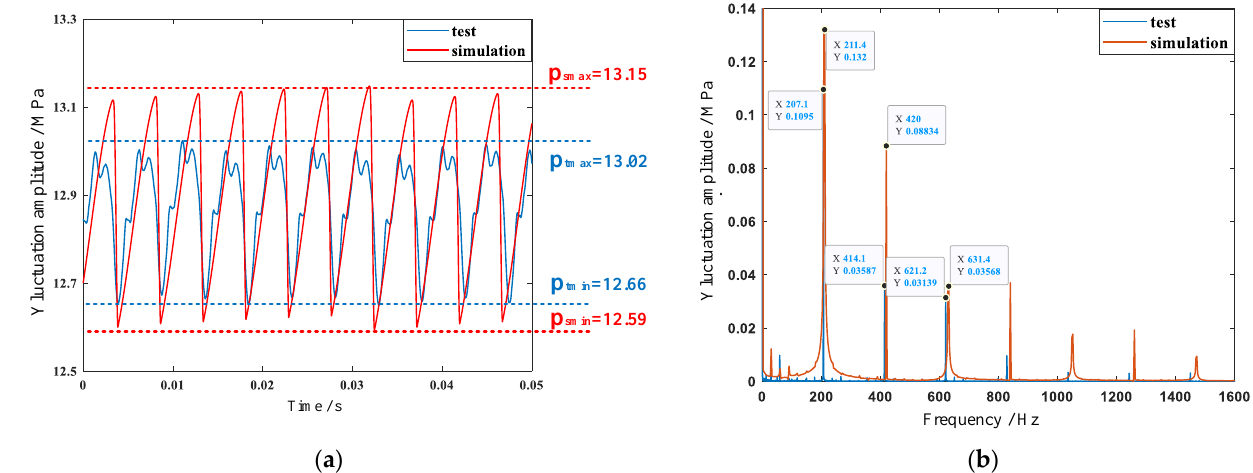
Figure 17. Comparison of simulation and experiment results. ( a ) Time domain comparative analysis chart; ( b ) frequency domain comparative analysis chart.